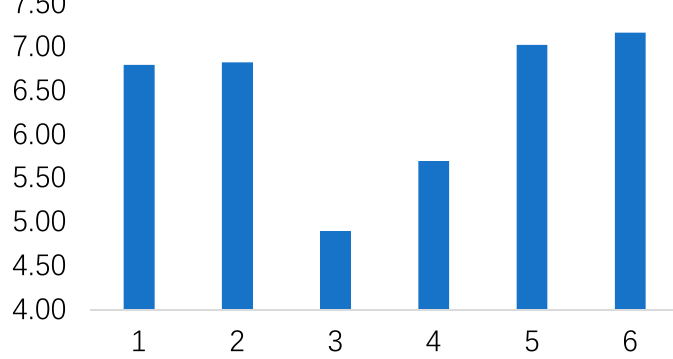
Table 5. The mean, SD, F value, P value of different variables and their ANOVA.